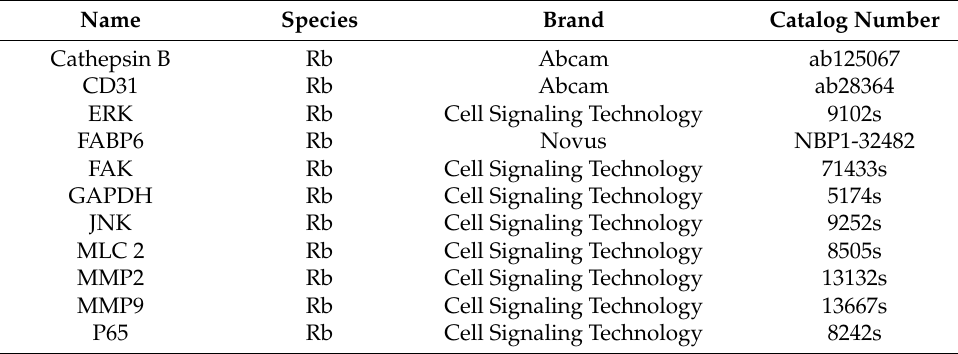
Table 1. Information on the